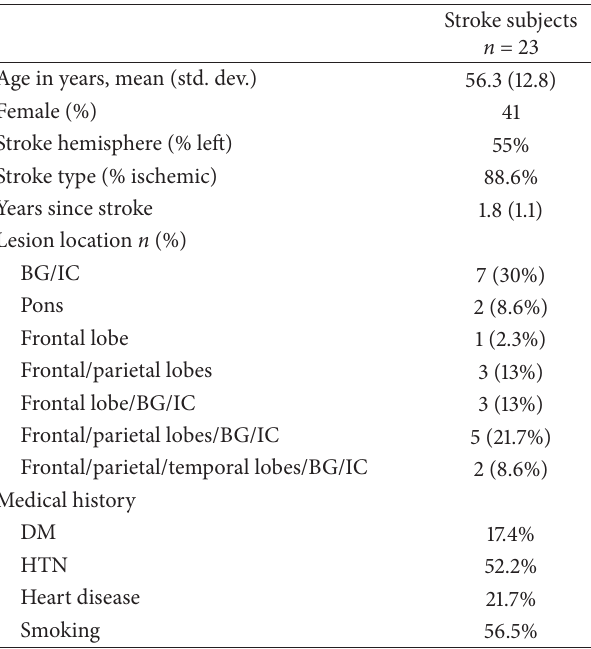
Table 1: Subject